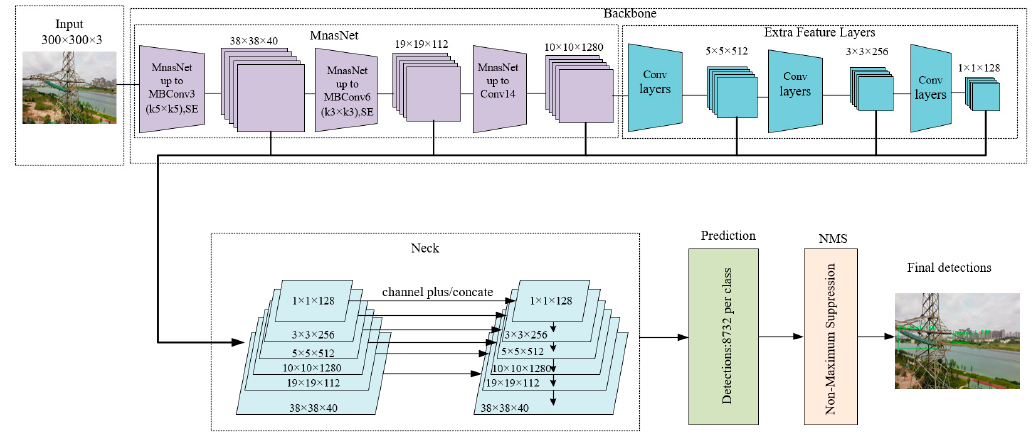
Figure 3. Improved SSD network (ISSD).